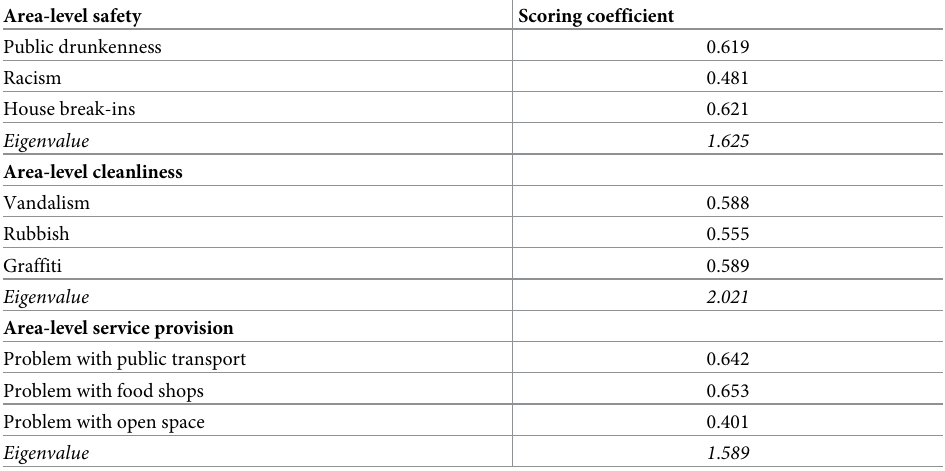
Table 3. Scoring coefficients from principal components